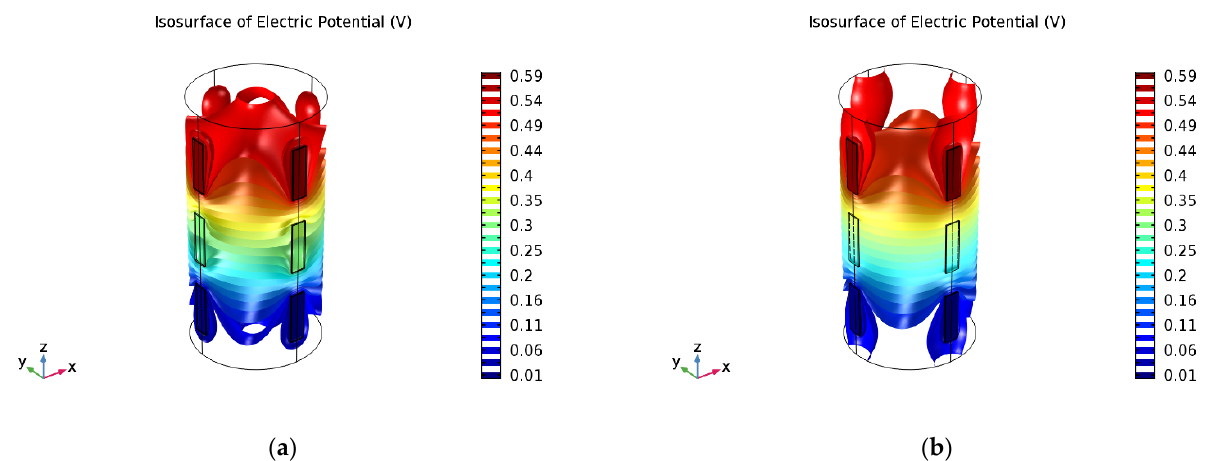
Figure 4. Resulting isosurfaces, calculated by Comsol with different simulated electrical conductiv- ity/resistivity of the electrodes. ( a ) electrical conductivity of electrodes: 1.4 × 10 6 S/m; ( b ) electrical resistivity of electrodes: 100 Ω m.